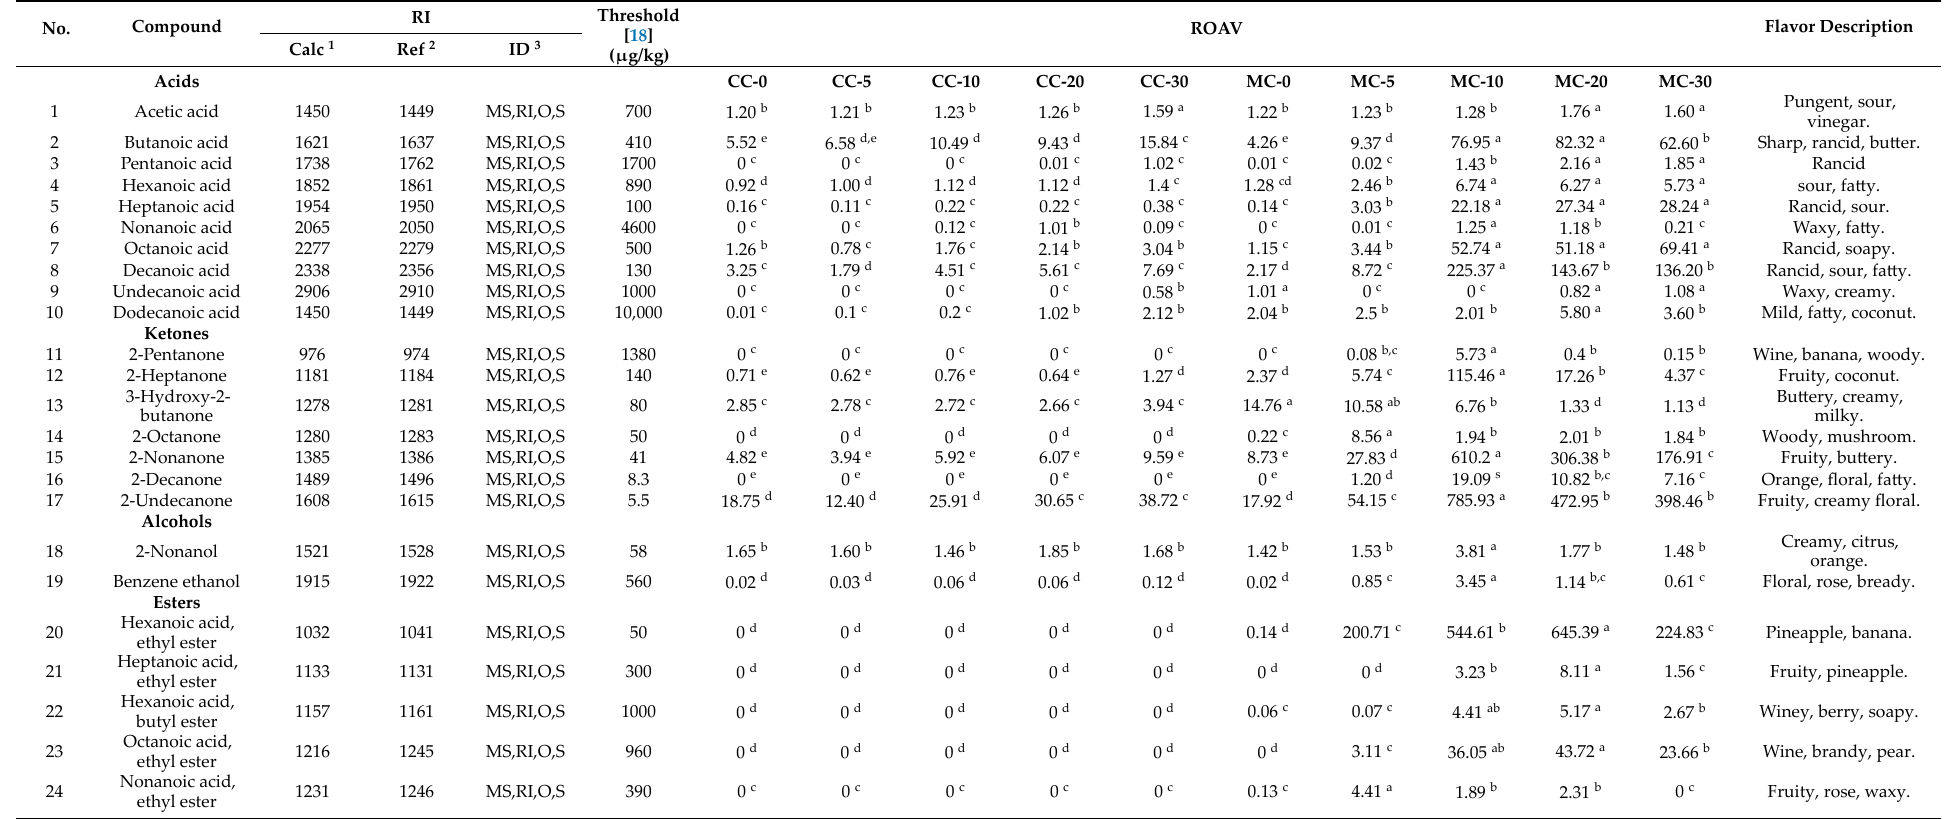
Table 1. The ROAV of 33 key aroma compounds identified in CC and MC during the 30‑day ripening period. (Different letters in the same row correspond to statistically significant differences ( p <